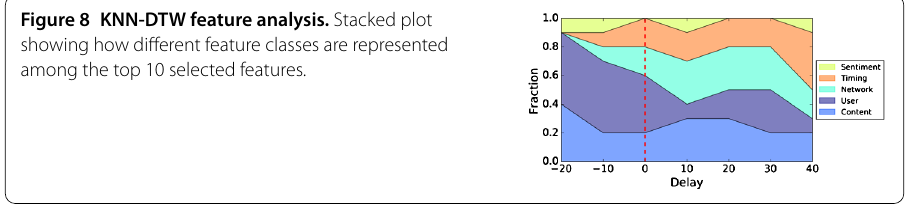
Figure 8 KNN-DTW feature analysis. Stacked plot showing how different feature classes are represented among the top 10 selected features.